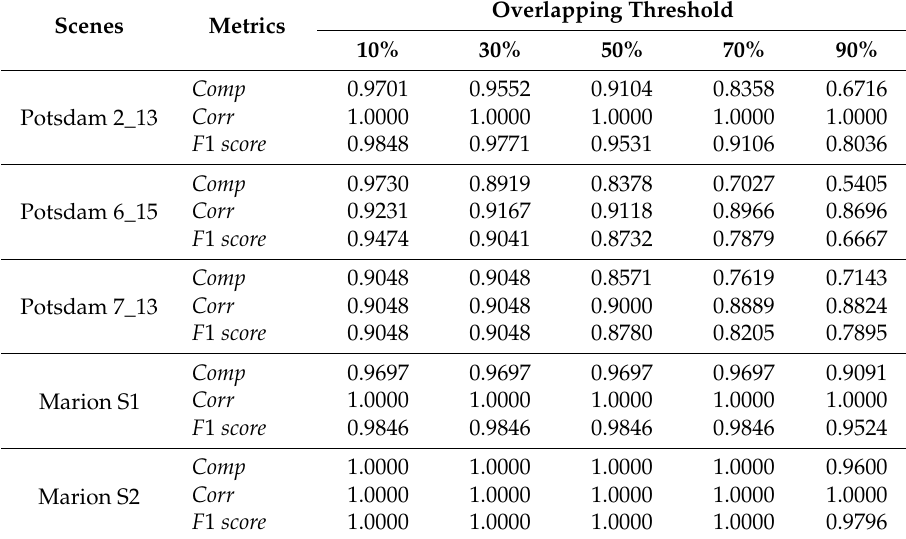
Table A1. Accuracies of CNN_ACM_1 at the scene level.